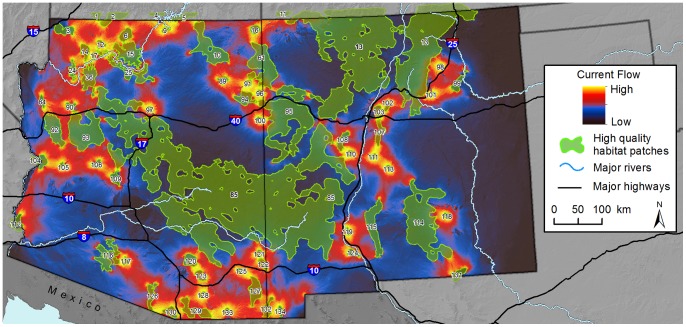
Model of maximum current flow used to estimate connectivity for pumas.Maps were displayed using a histogram equalize stretch. High quality habitat patches are uniquely numbered for reference. Background maps were produced using data obtained from the U.S. Geological Survey’s Earth Resources Observation and Science Center.